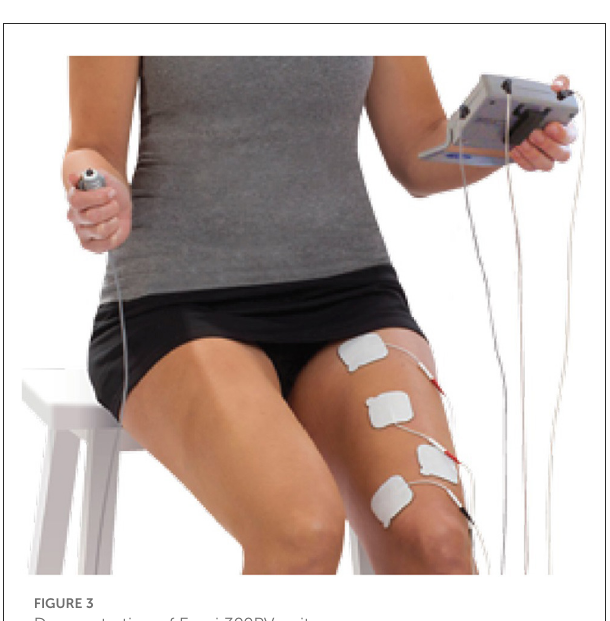
FIGURE3 Demonstration of Empi 300PV